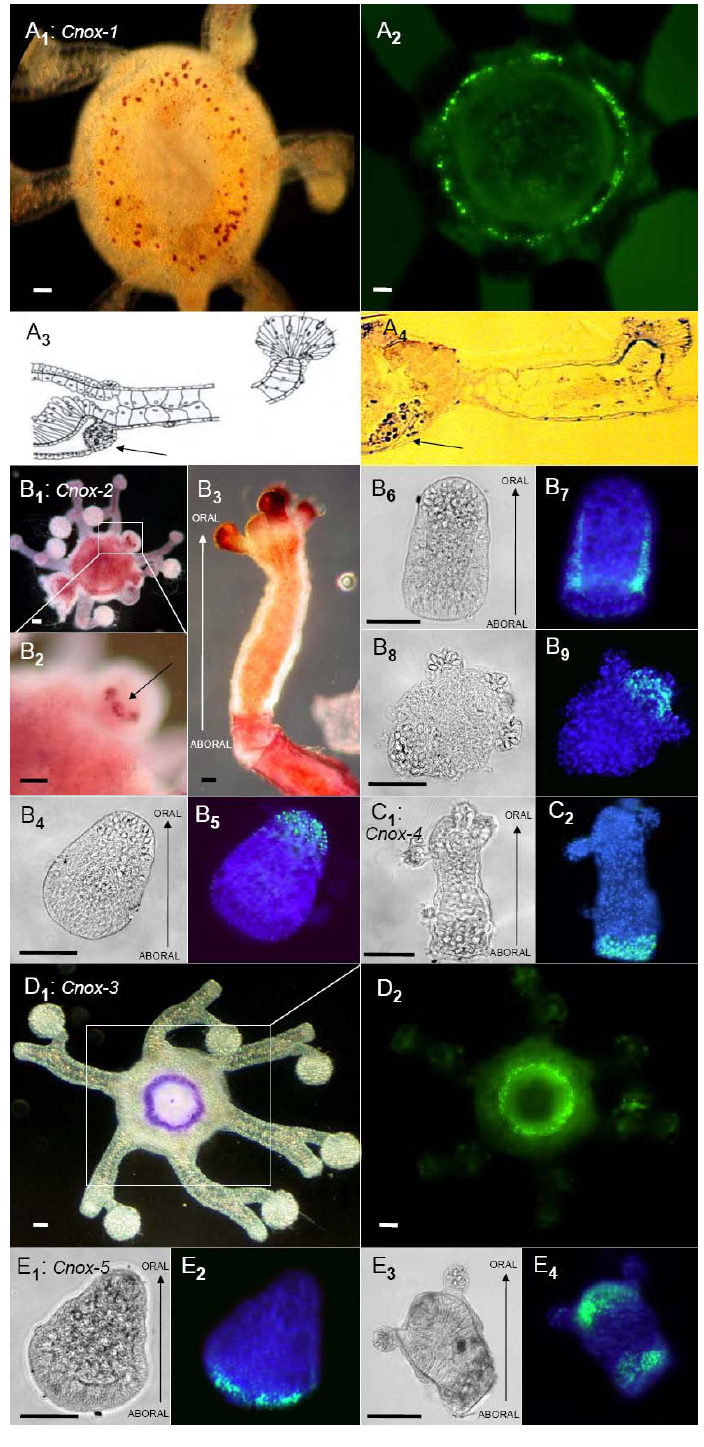
Figure 3. In situ expression of Hox-like genes in the hydrozoan Eleutheriadichotoma. The five Hox-like genes, Cnox- 1 to Cnox- 5, display differential spatio-temporal expression patterns along the oral-aboral body axis. Cnox- 1 (A 1 –A 4 ) is expressed ectodermally in the so-called ‘‘Nesselring’’, an area of undifferentiated cells liningthe ringcanal ofmedusae (crosssection:A 3 , A 4 ). Cnox- 2 is expressed inthe entoderm ofdeveloping medusa buds (B 1 , B 2 ),in 2- day-old planula larvaeectodermallyandorally(B 5 ),in5-day-oldplanula larvaealongthebodycolumnectodermally(B 7 ) andatthe oralpoleofprimary(B 9 ) and adult polyps (B 3 ; single polyp with 4 tentacles). Cnox- 4 is exclusively expressed at the aboral pole of primary polyps (C 2 ). Cnox- 3 expression perfectly marks the most ectodermal oral part of the manubrium (D 1 , D 2 ). Cnox- 5 shows a remarkable pattern of expression moving from aboral only in the planula larva (E 2 ) to both oral and aboral simultaneously in the metamorphosing polyp (E 4 ). NBT/X-phosphate (A 1 , A 4 , B 1 –B 3 , D 1 ) and fluorescein-labeled probes (A 2 , B 5 , B 7 , B 9 , C 2 , D 2 , E 2 , E 4 ). Signals in B 5 , B 7 , B 9 , C 2 , E 2 and E 4 are overlaid with DAPI staining. Morphologies are shown in light microscopy (B 4 , B 6 , B 8 , C 1 , E 1 , E 3 ). Scale bar is 50 m m. A 2 , D 1 , E 1 –E 4 are reprinted with permission from Elsevier Publishers [11].